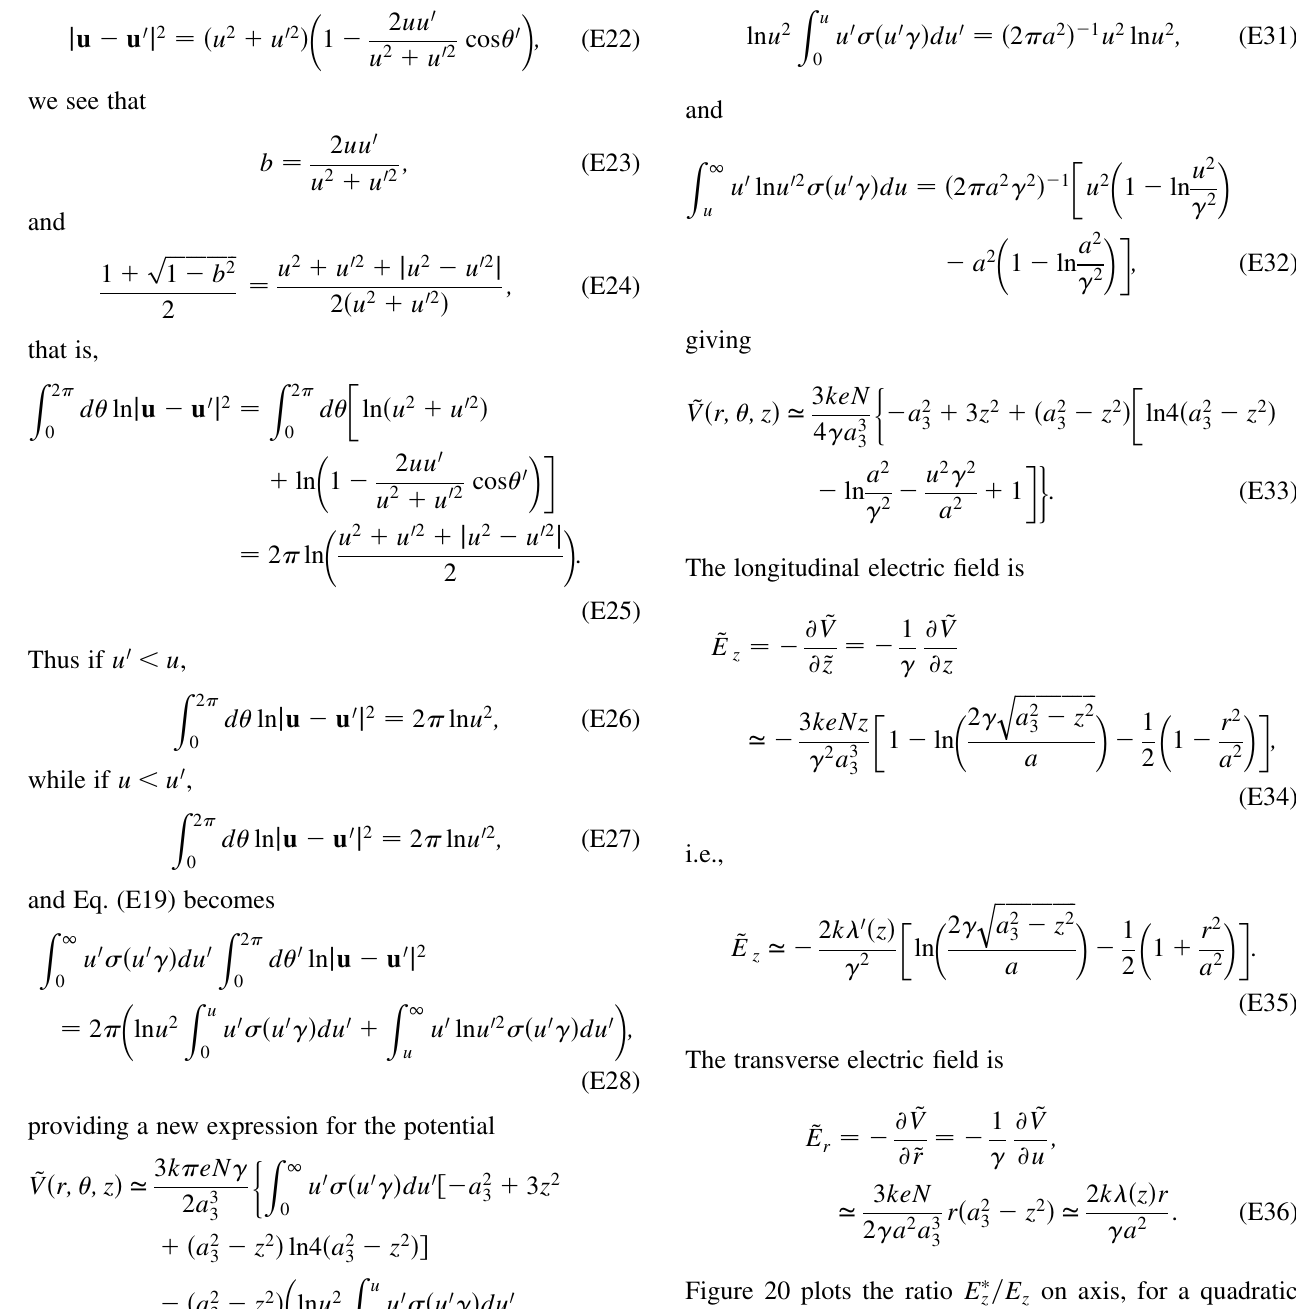
Figure 20 plots the ratio E (cid:15) density profile [Eq. (E13)]. E (cid:15) electric field obtained from direct integration of Eq. (E1). One can see an excellent agreement with the approximate expression Eq. (E35) up to the limit z ’ a